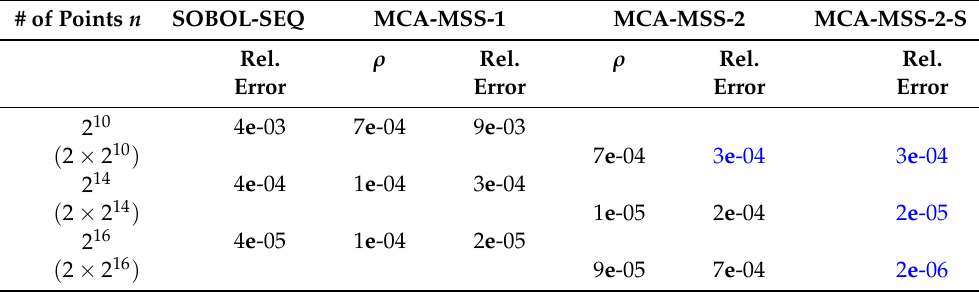
Table 3. RE for AE of D ≈